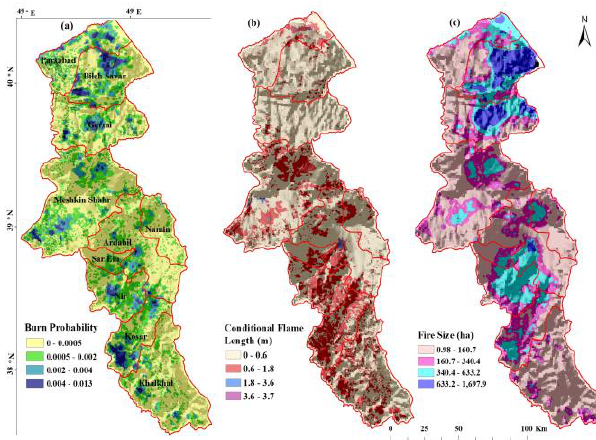
Figure 3. Output maps of BP (a), CFL (b), and FS